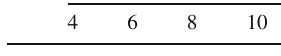
Table 1 Maximum amplitude a max for several values of n